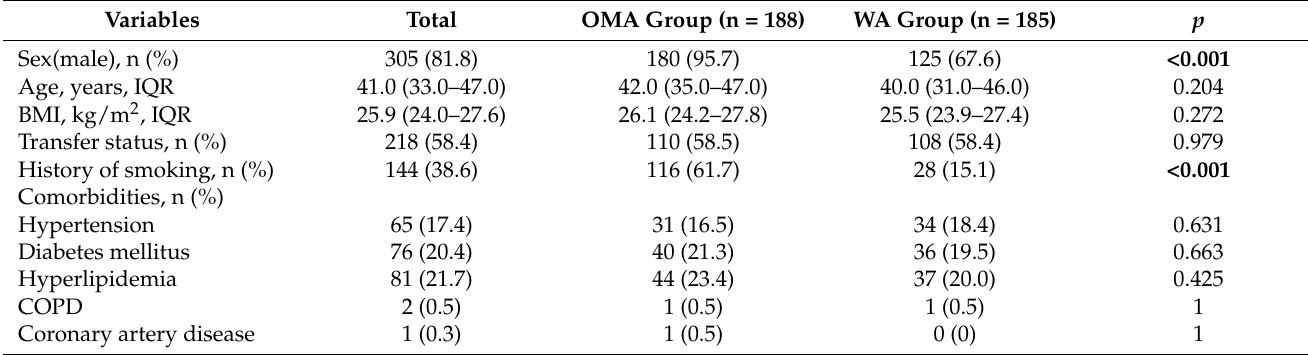
Table 1. Comparison of clinical characteristics in patients in OMA group and WA